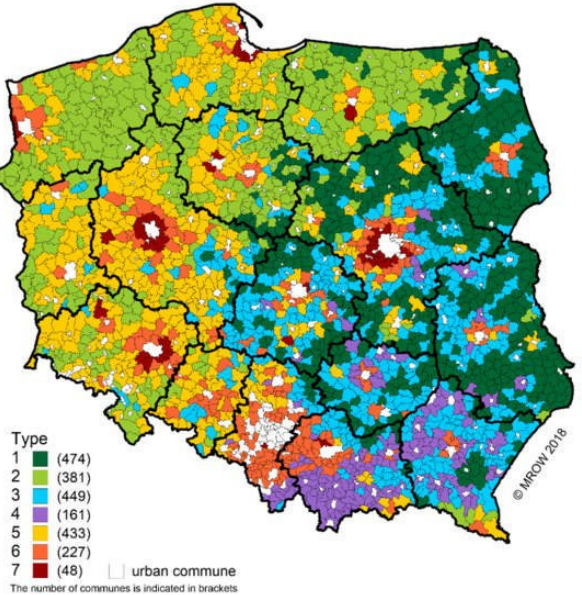
Figure 5. Spatial distribution of the types of rural areas according to Stanny et al. [59].